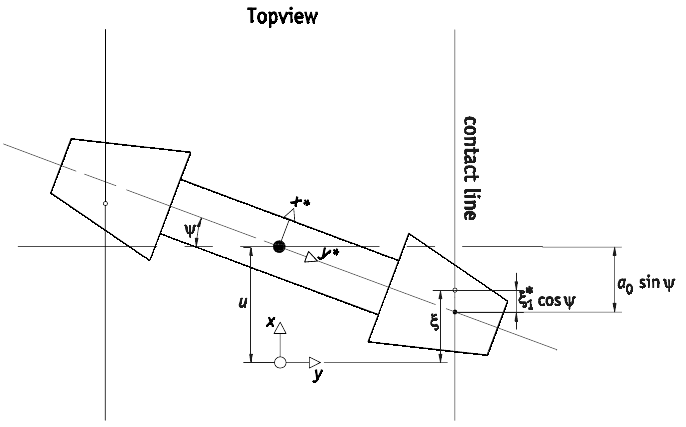
Fig. 4. The contact point shift defined in the roller-body frame (oxyz). In particular, the contact point shift at the right wheel is